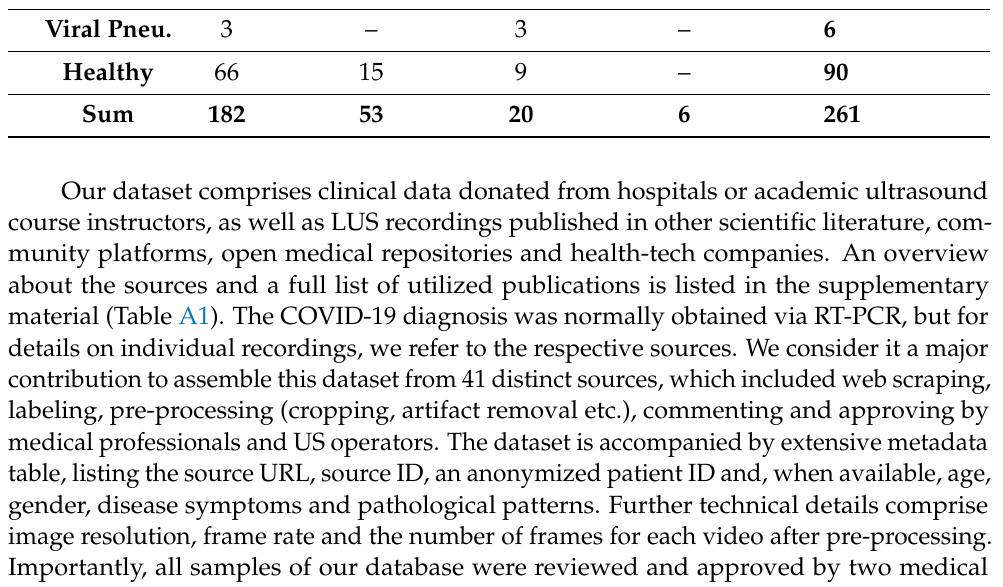
Bacterial Pneu. 49 Viral Pneu.